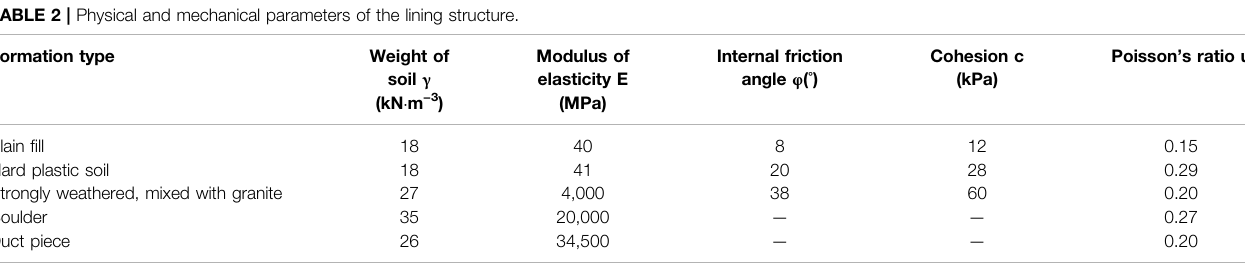
four stages: fi rst stage: calculation of the initial ground stress.